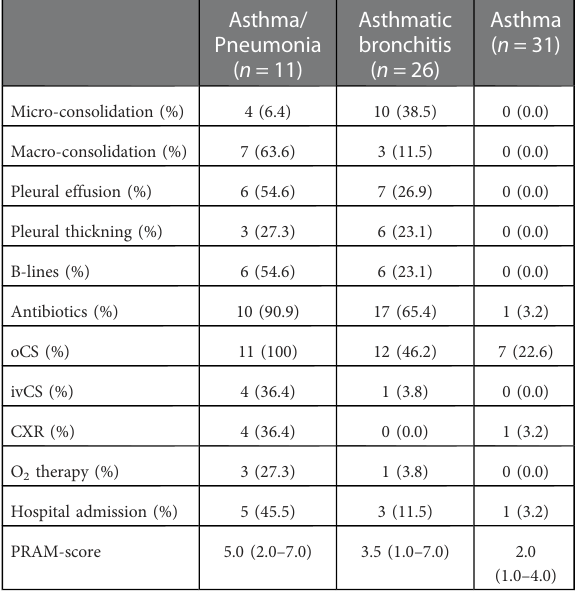
TABLE 2 Description of LUS characteristics and follow-up by clinical